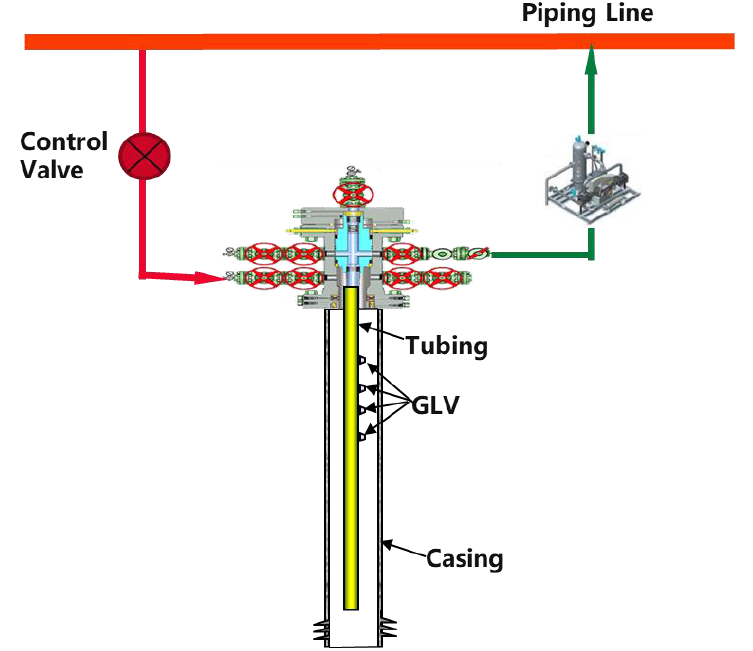
Figure 2. Fuling field gas production demand vs. actual gas production.